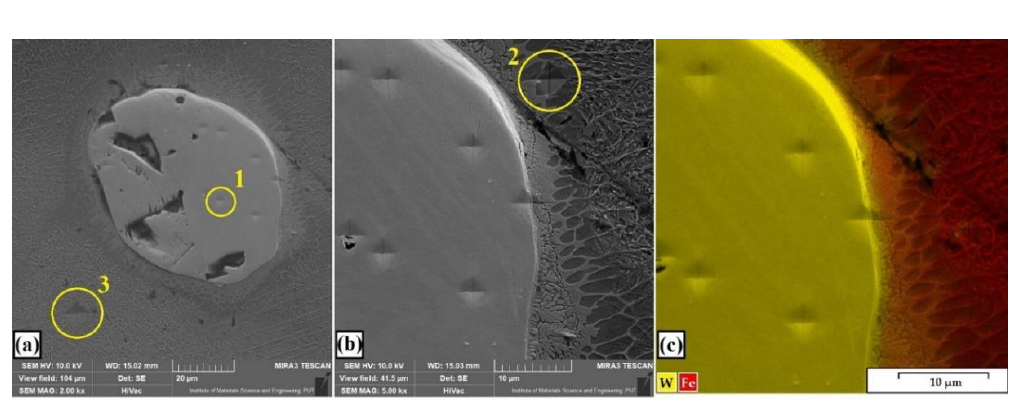
Figure 17. Example of microstructure within area of nanoindentation: ( a ) WC carbide in W–Cr matrix; ( b ) the boundary between carbide and matrix; ( c ) EDS mapping of nanoindentation area.